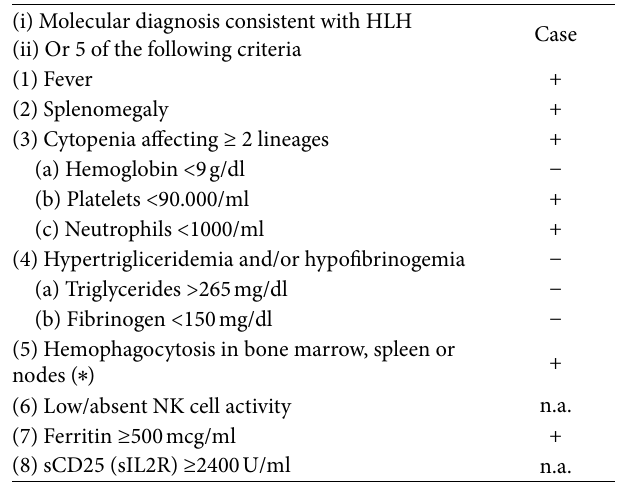
Table 2: Diagnostic criteria of HLH. Table 3: HScore.